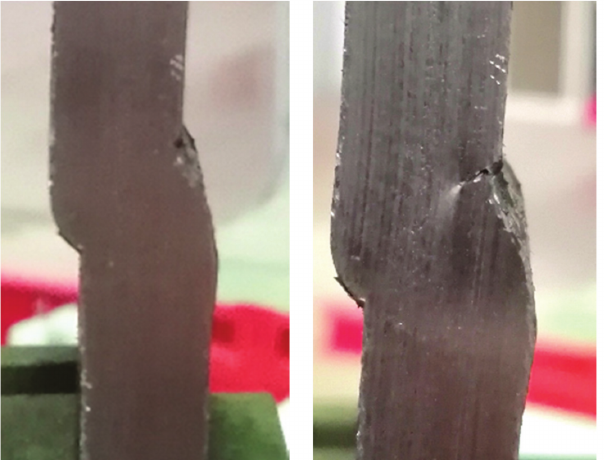
Figure 11. Tensile test specimens during the experiment (misalignment model with slight excess root penetration and undercut) from the initial state to fracture.